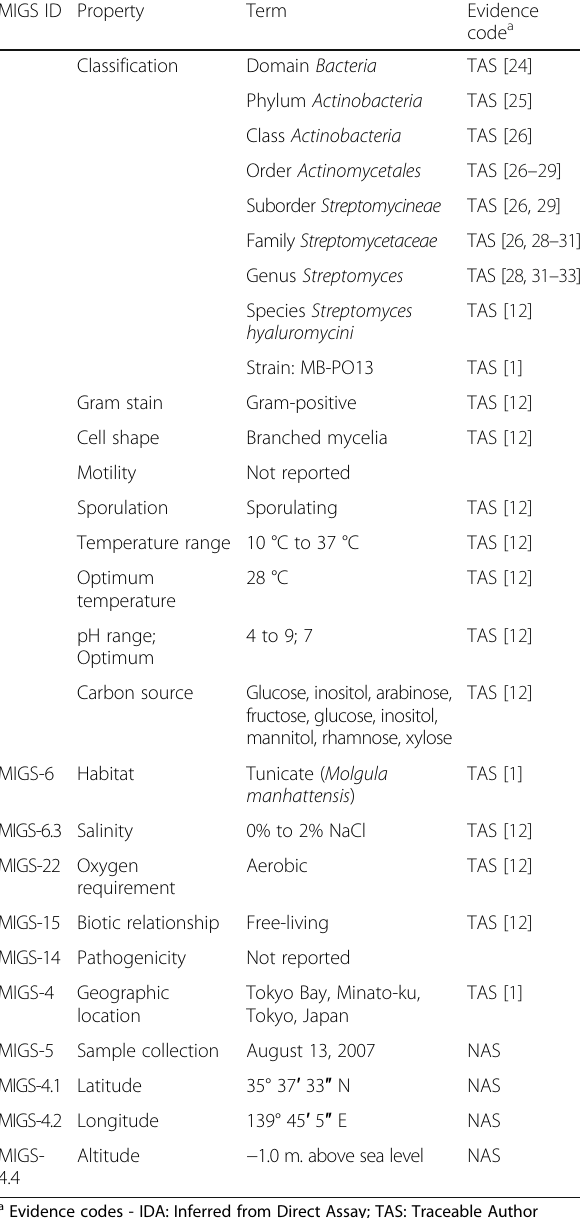
Table 1 Classification and general features of